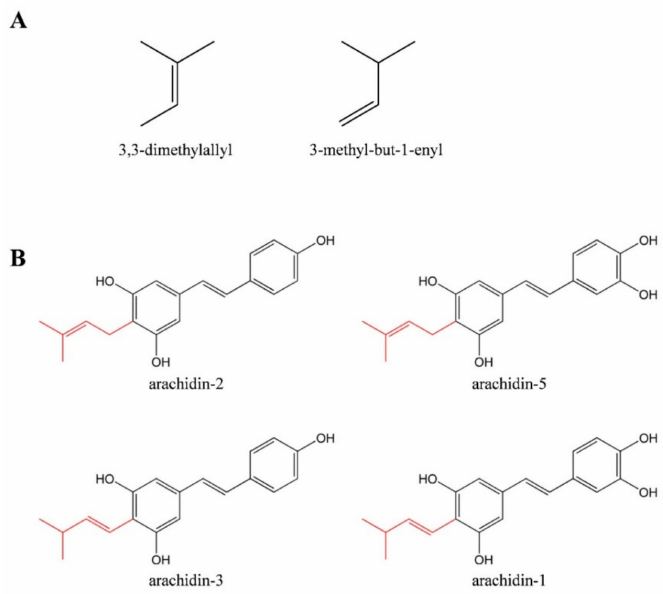
Figure 1. ( A ) Prenylation patterns present on prenylated stilbenoids. ( B ) Chemical structures of four main prenylated stilbenoids identified in elicited peanut hairy root culture. All compounds are shown as their trans isomers. Prenylated groups are shown in